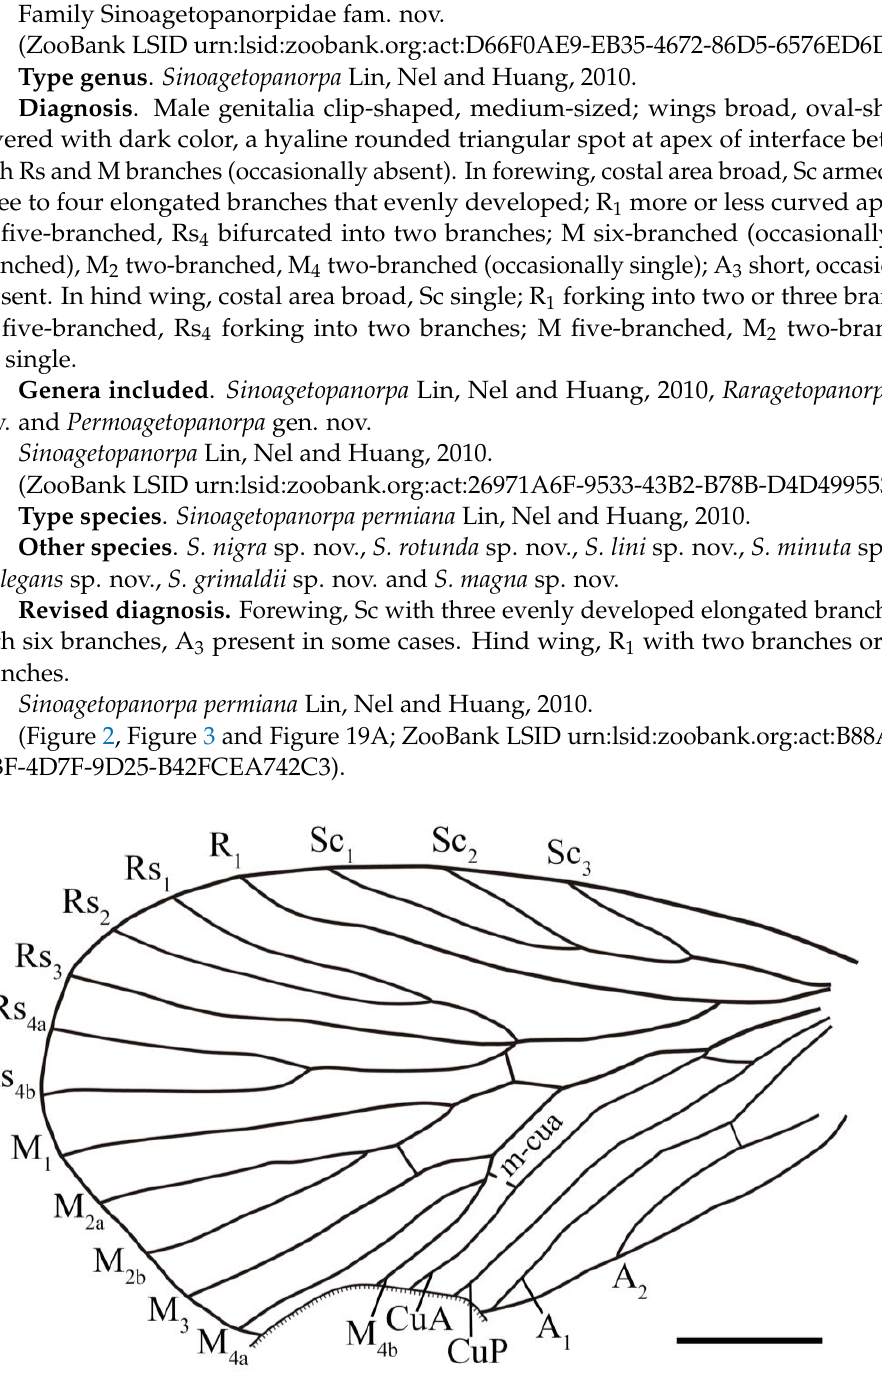
Figure 2. New line drawing of Sinoagetopanorpa permiana Lin, Nel and Huang, 2010, based on NIGP143428. Scale bar represents 1 mm.